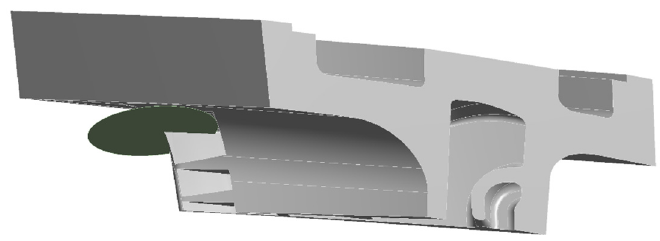
Figure 10. Crack modeling through a circular surface at the PETE.